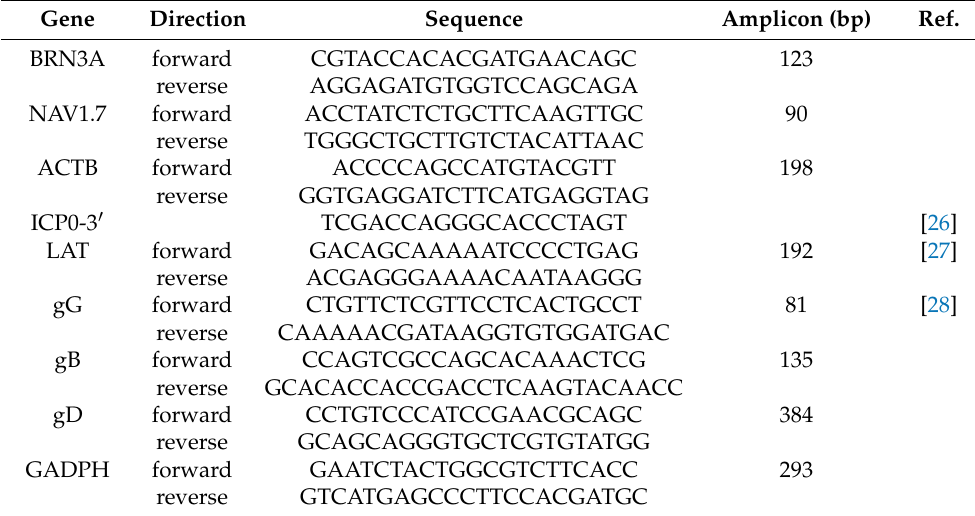
Table 1. PCR primers and size of the